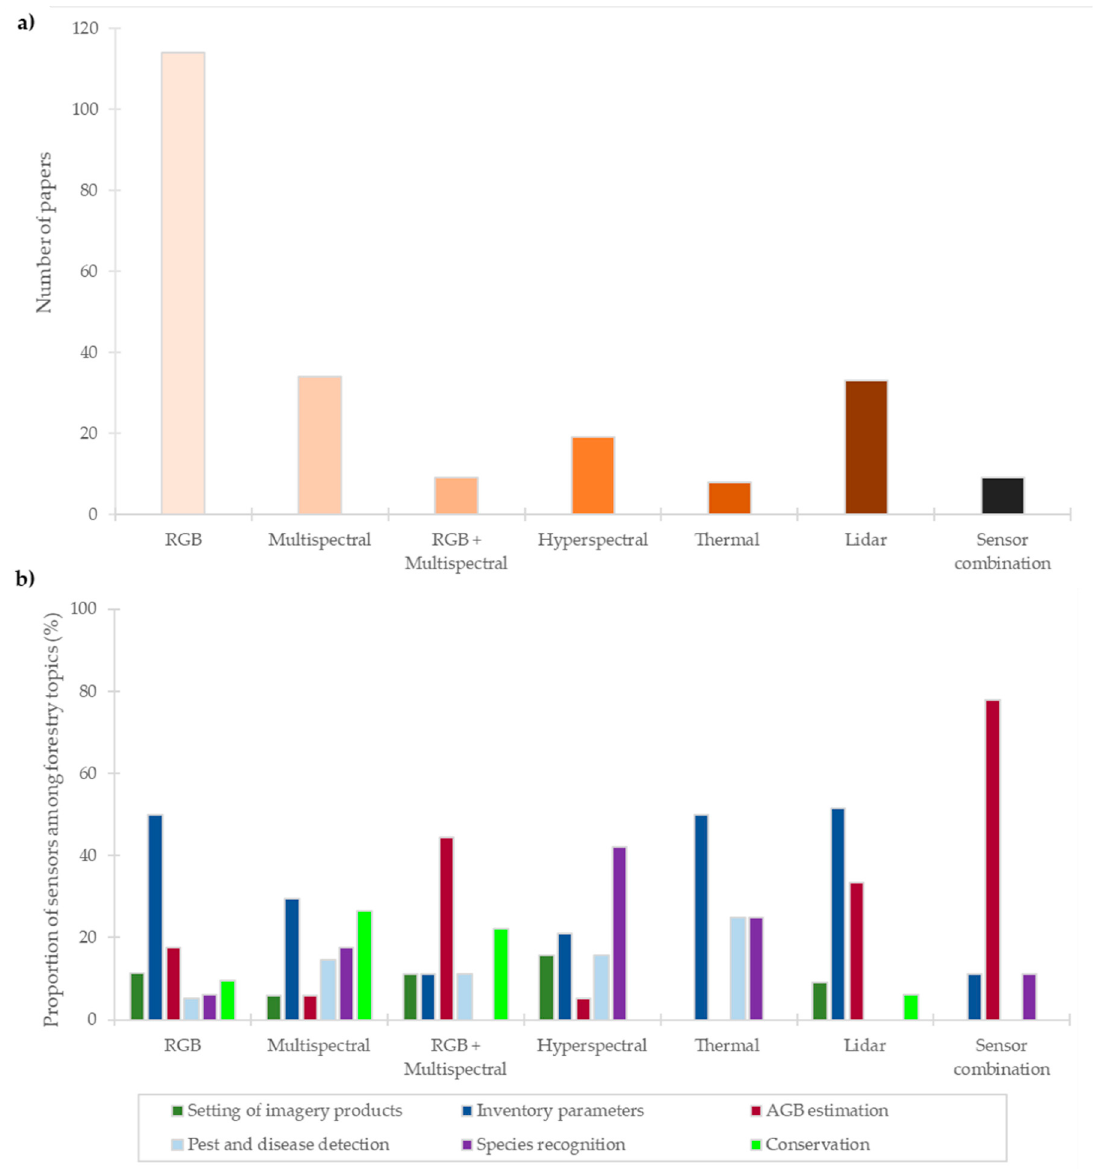
Figure 7. ( a ) Distribution of different types of sensors in the reviewed dataset; ( b ): percentage of studies that used a given sensor, by forestry topics.